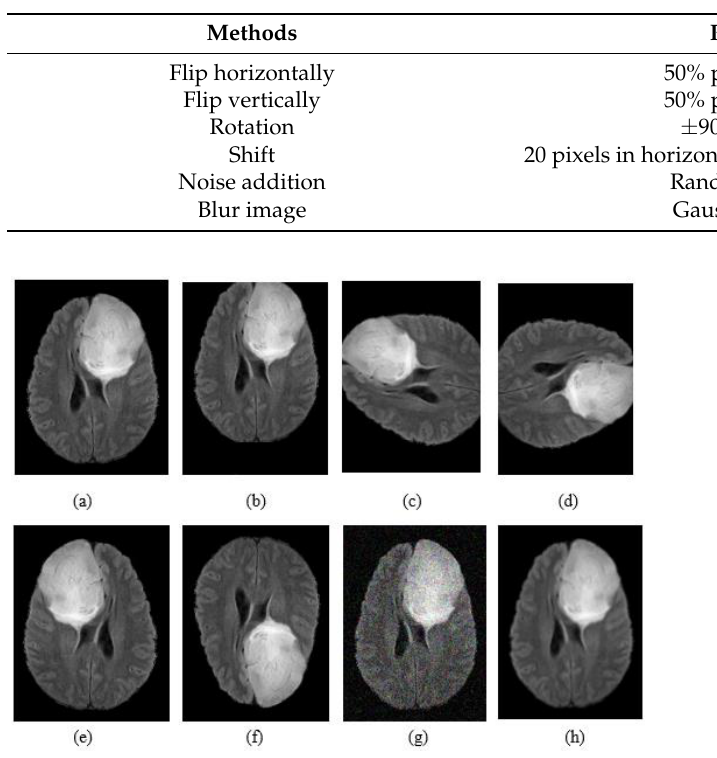
Figure 2. Example of data augmentation: ( a ) FLAIR image; ( b ) shift; ( c ) rotation +90°; ( d ) rotation - 90° . ( e ) Flip horizontally; ( f ) flip vertically; ( g ) noise addition; ( h ) blur. − 90 ◦ . ( e ) Flip horizontally; ( f ) flip vertically; ( g ) noise addition; ( h )